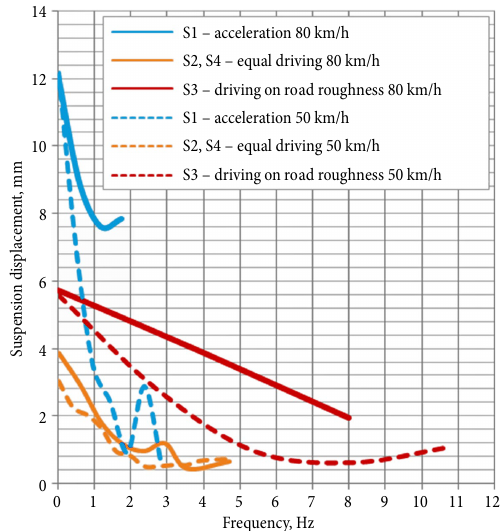
Fig. 7. Frequency characteristics of the vehicle suspension motion at different driving